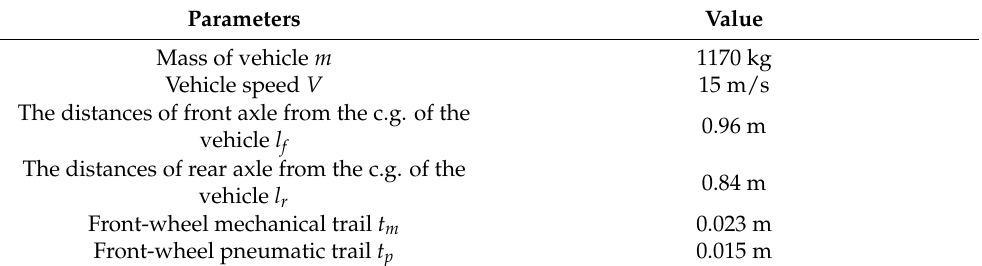
Table 2. Vehicle model